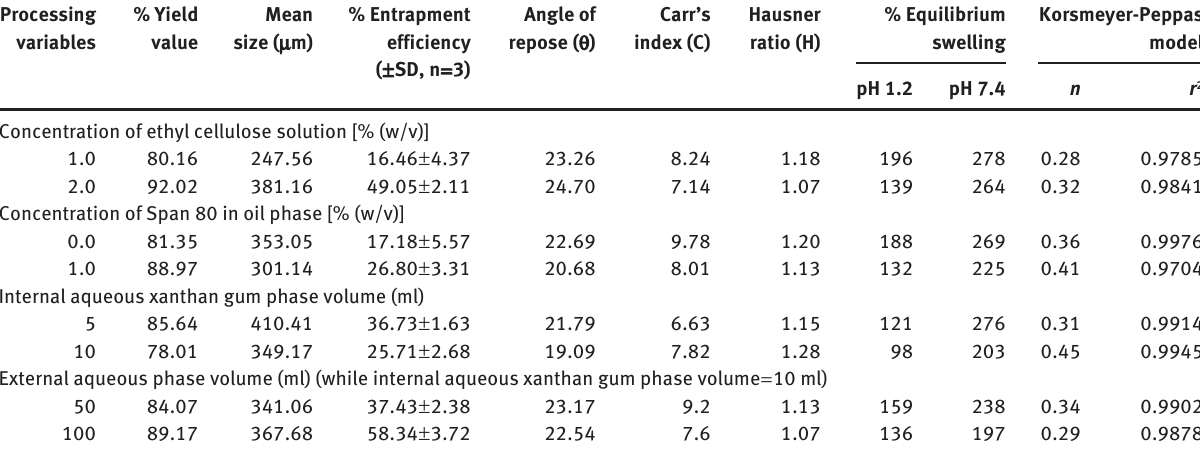
Table 1 Influence on variation in process parameter on the in vitro physicochemical characteristics of aspirin-loaded xanthan-gum- facilitated ethyl cellulose microparticles.